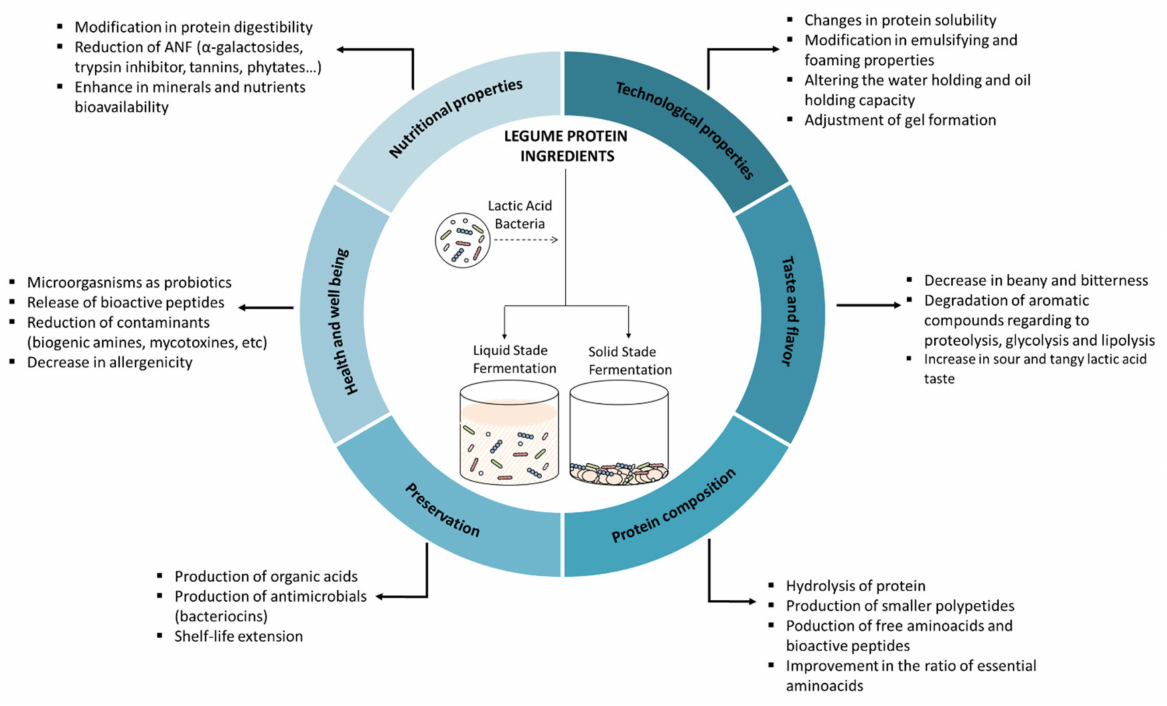
Figure 1. Schematic depicting the effect of lactic acid fermentation on legume